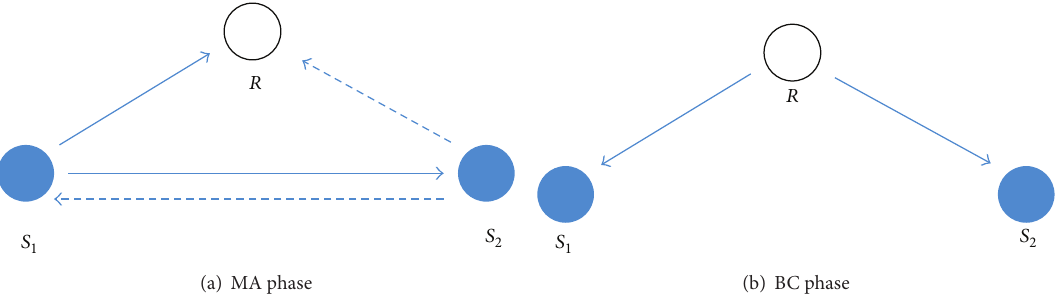
Figure 1: System model of TW relay